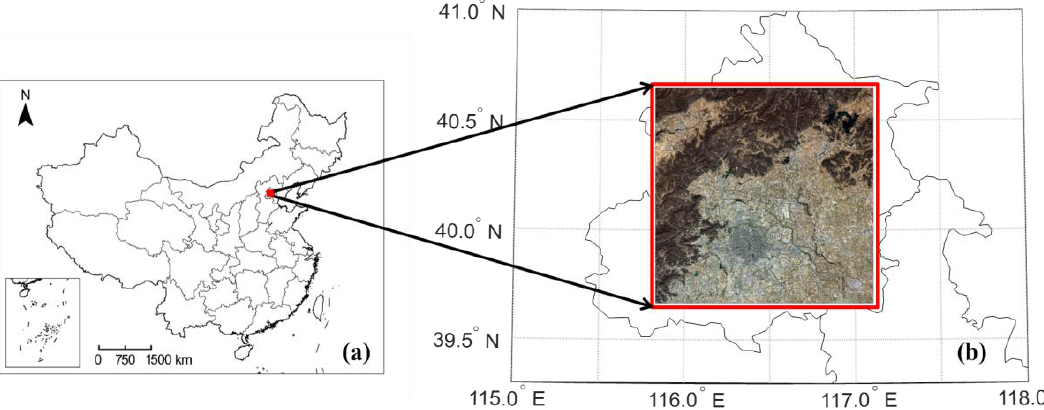
Figure 1. ( a ) Location of study site, Beijing; and ( b ) study area covered by the Sentinel-2 scene T50TMK (red box).